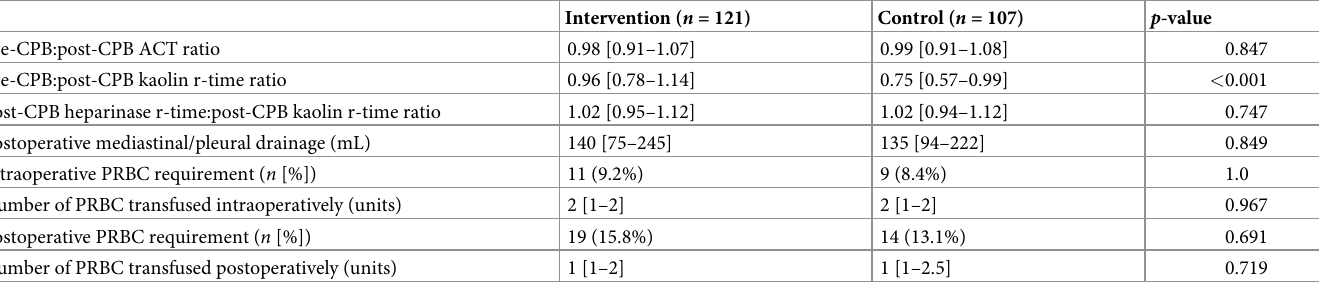
Table 3. Secondary endpoints for participants allocated to the intervention (PRODOSE model) and control (fixed 1:1 ratio)